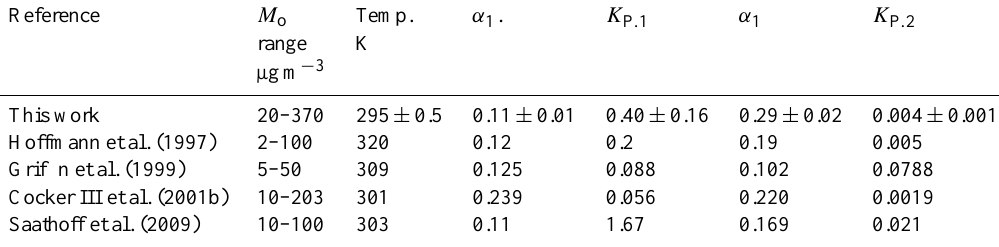
Table 8. Comparisons of the two-product equation parameters obtain from this work and proposed in the literature for comparable study. Reference